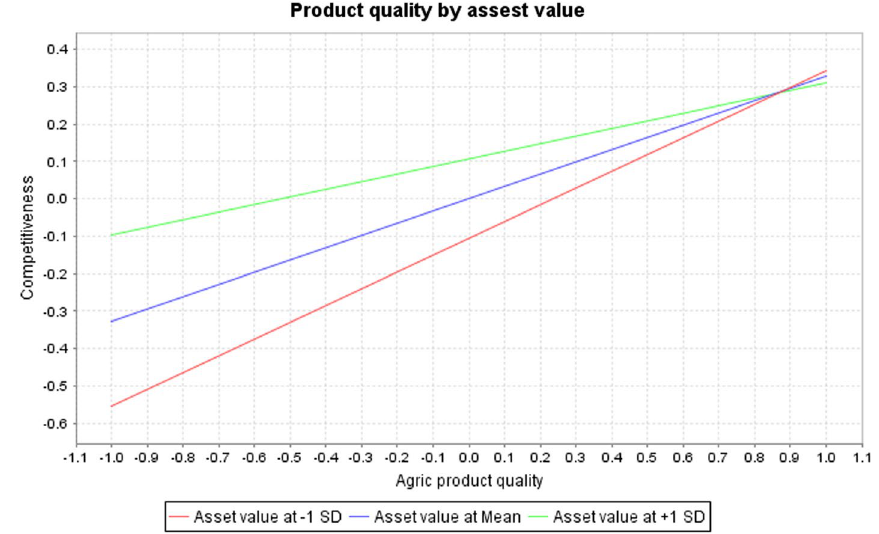
Fig. 5 The moderated effects on competitiveness of product quality by asset